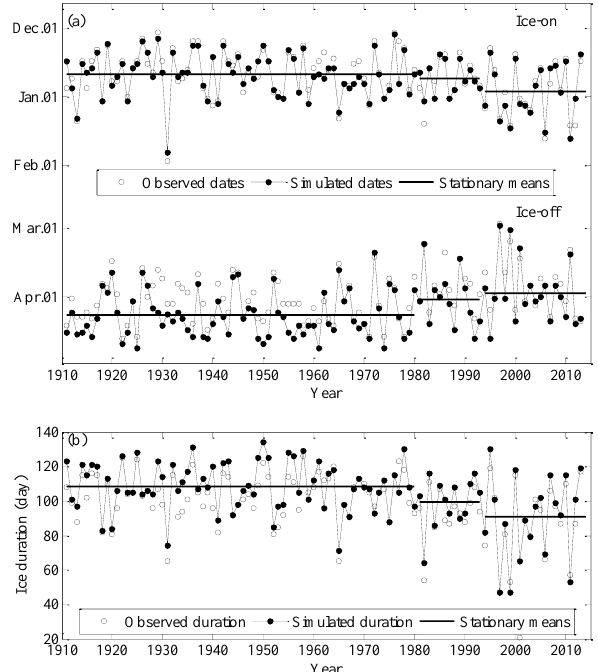
Figure 4. Observed and simulated (a) ice-on and ice-off dates and (b) ice cover duration. The annual ice cover was plotted in the first year of the winter, e.g., the winter 1911–1912 was plotted in the year 1911. Stationary means for three selected periods are denoted by solid